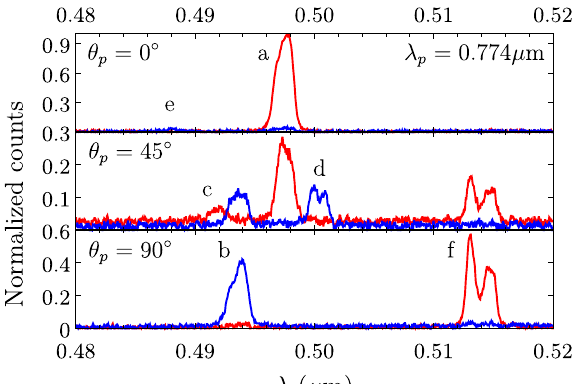
Figure 2. Spectrally-resolved single photon counting for the idler channel. Red and blue lines correspond to the x and y polarizations, respectively. From top to bottom the corresponding pump polarization angles are θ p = 0 ◦ , θ p = 45 ◦ , and θ p = 90 ◦